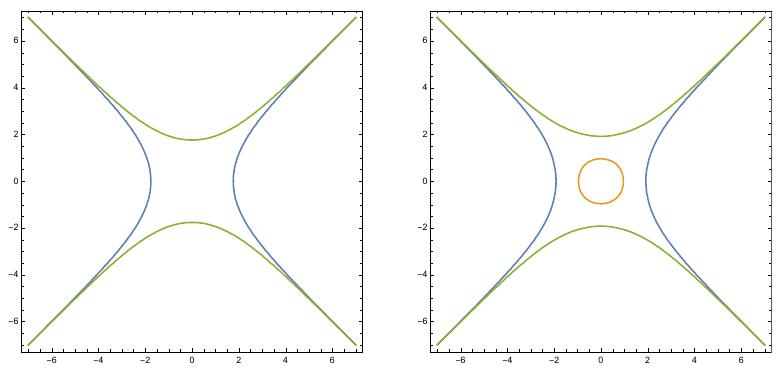
Figure 11 . Amoebas of F 0 quiver at k = 4 (left) and k = 5